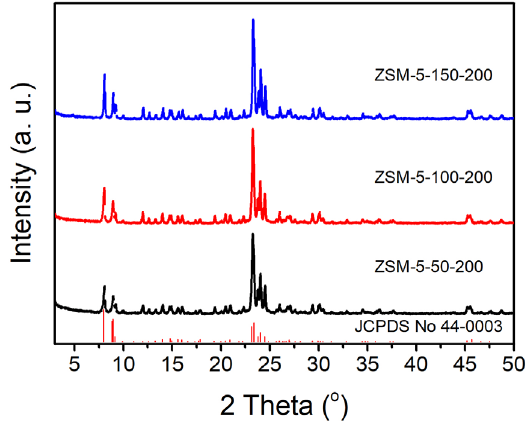
Figure 3. N 2 physisorption isotherms of ZSM ‐ 5 with Si/Al ratio of 100 synthesized with different amounts of toluene.